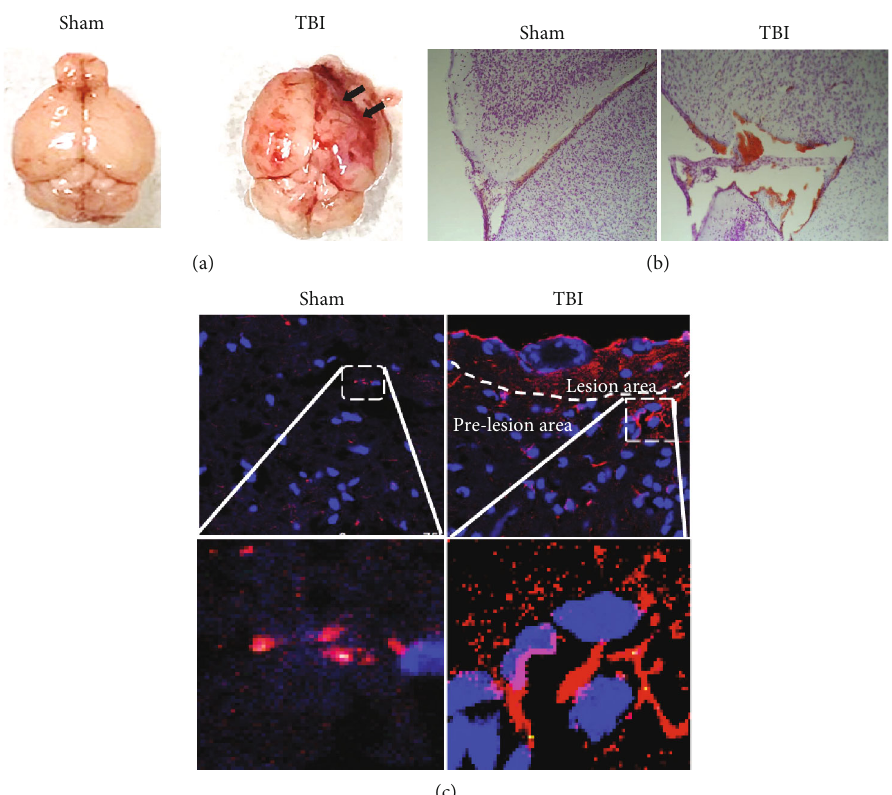
Figure 1: Closed-head weight drop-induced neuroin fl ammation. Representative images of (a) whole brains and 0.1% crystal violet staining indicate hemorrhage/in fl ammatory changes (b) in TBI brains as compared to sham control mouse brains ( n = 6 mice/group). Representative microphotographs show increased GFAP immunoreactivity indicating an increased number of activated astrocytes in TBI mice (72 h) as compared to sham control mice (c). Image magni fi cations: (b) 200x and (c) 630x.